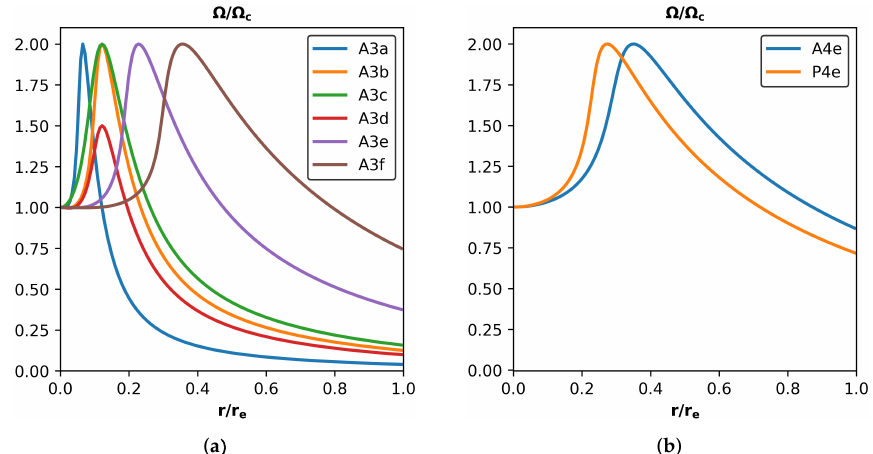
Figure 1. Rotation rate vs. radius on the equatorial plane for ( a ) models A3 and ( b ) models 4e in Table 1. Values of the rotation rate are relative to the central value, while values of the radius are relative to the equatorial radius of the star. Version March 7, 2022 submitted to Universe